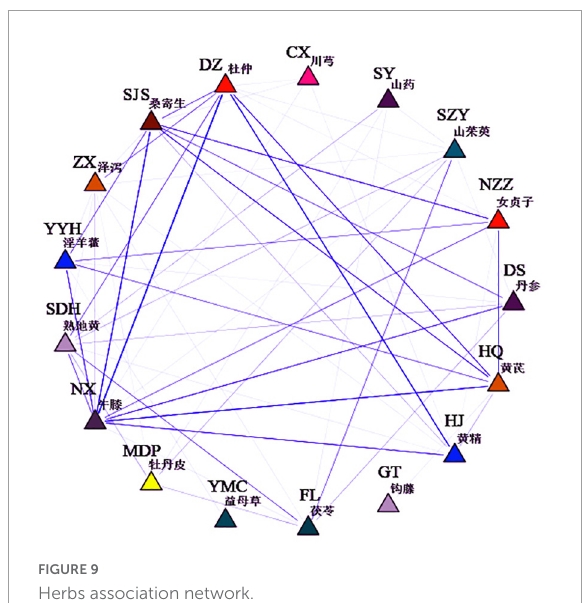
FIGURE9 Herbs association